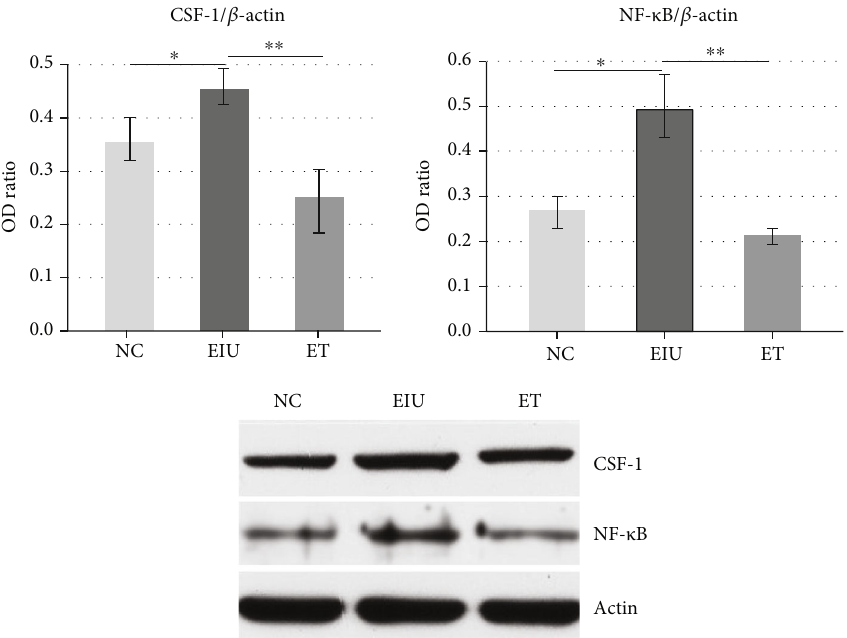
Figure 5: Western blot of CSF-1 and NF- κ B P65 in ICB. The protein expression of CSF-1 and NF- κ B P65 in the EIU group were signi fi cantly higher than that in the NC group ( ∗ P < 0 : 05 ) and ET group (CSF-1: F = 31 : 081 , ∗∗ P < 0 : 05 ; NF- κ B P65: F = 53 : 861 , ∗∗ P < 0 : 05 ). All data shown as mean ± standard deviation from ten independent experiments.